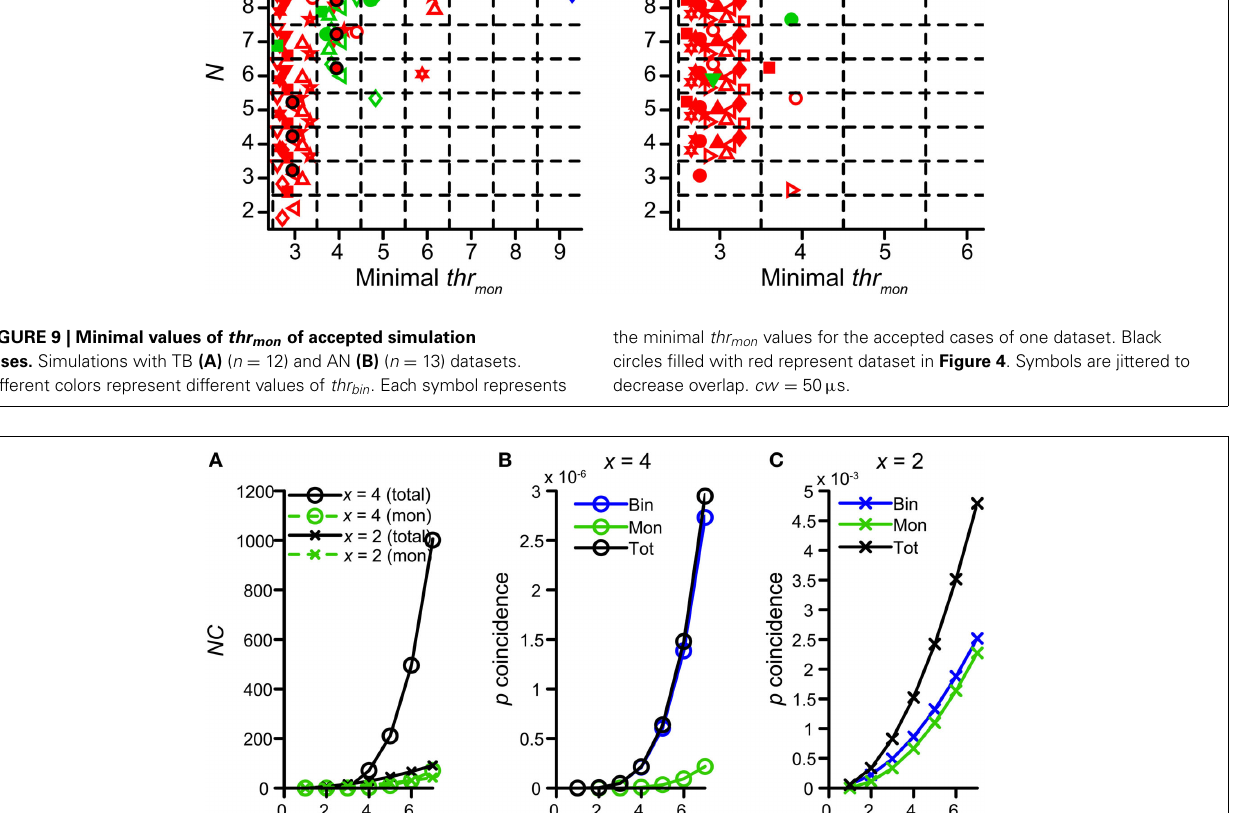
FIGURE 10 | Graphical display of the argument of Colburn et al. (1990). See text for detailed explanation. (A) Number of combinations for either 4 (circles) or 2 (crosses) coincidences, as a function of N . Green traces indicate the possible number combinations monaurally, i.e., twice the number of combinations of either x = 2 or 4 out of N . Black traces indicate the total (monaural + binaural) possible number of combinations,